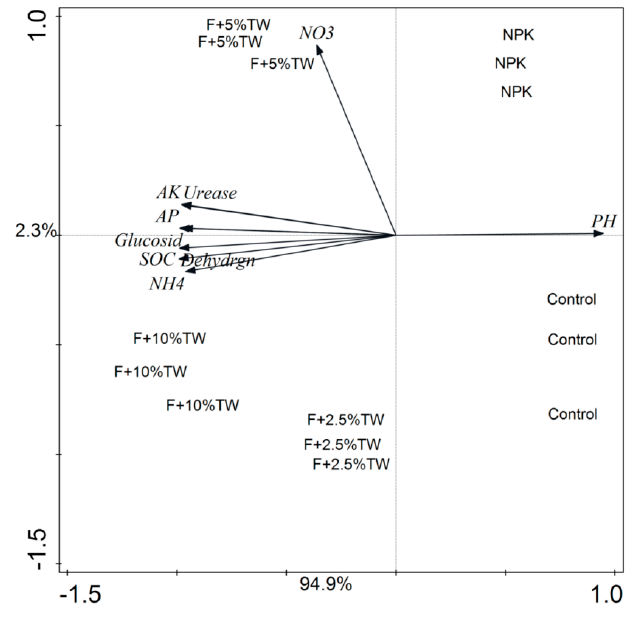
Figure 7. Principal component analysis (PCA) of soil enzymes and soil chemical properties after wheat wheat harvested.